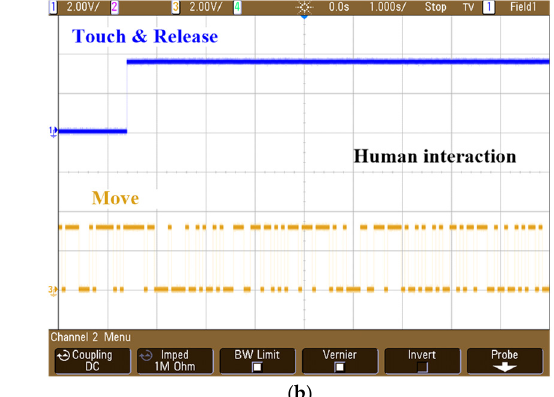
Figure 10. Capacitance readout circuit output waveforms when ( a ) an object is on the electrode; ( b ) a finger touches the electrode.